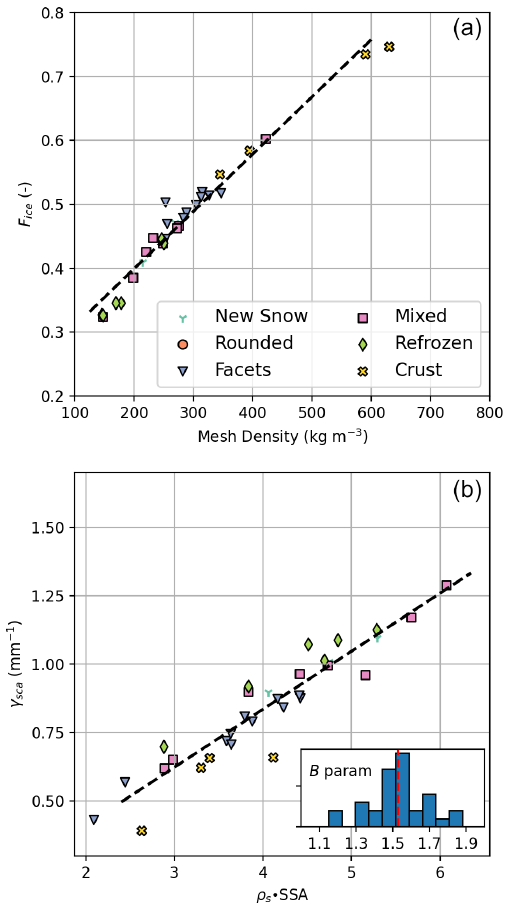
Figure 13. Optical properties for λ = 1000nm computed from µCT photon tracking compared against sample physical properties. shown in dashed black lines. Marker shapes and colors are indica- tive of the observed grain forms determined through visual assess- ment during snow pit analysis. Note that in panel (b) a histogram of the estimated B parameters for all of the µCT samples is shown, inset. B mean = 1 . 53 is shown as the vertical red line.